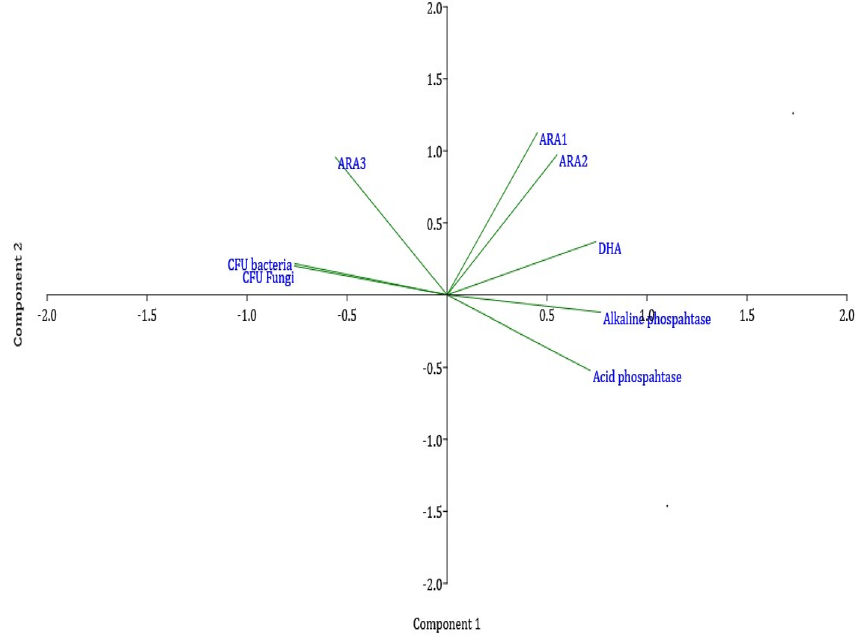
Figure 8. PCA analysis of different parameters for organic and conventional